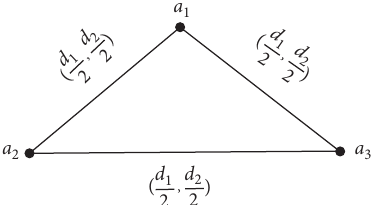
Figure 4: ζ is a ( d RG.